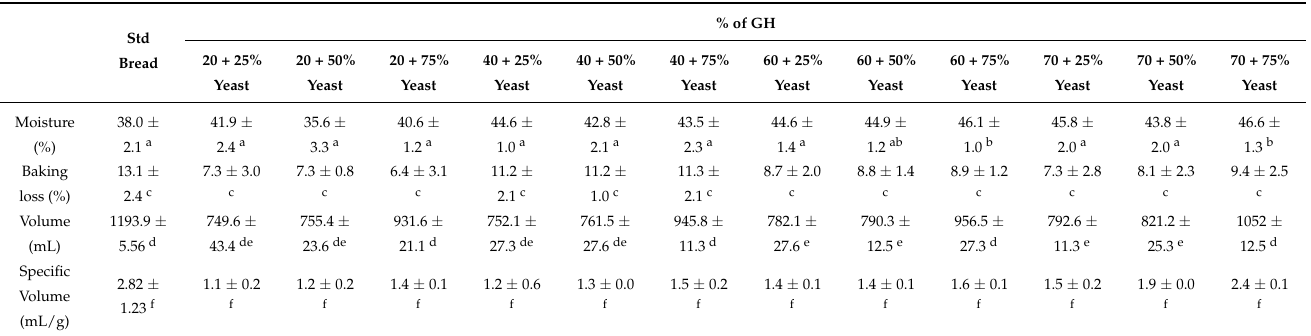
Table 2. The characteristics of the standard bread versus GH bread with promoters (20–70%) and partial replacement with yeast